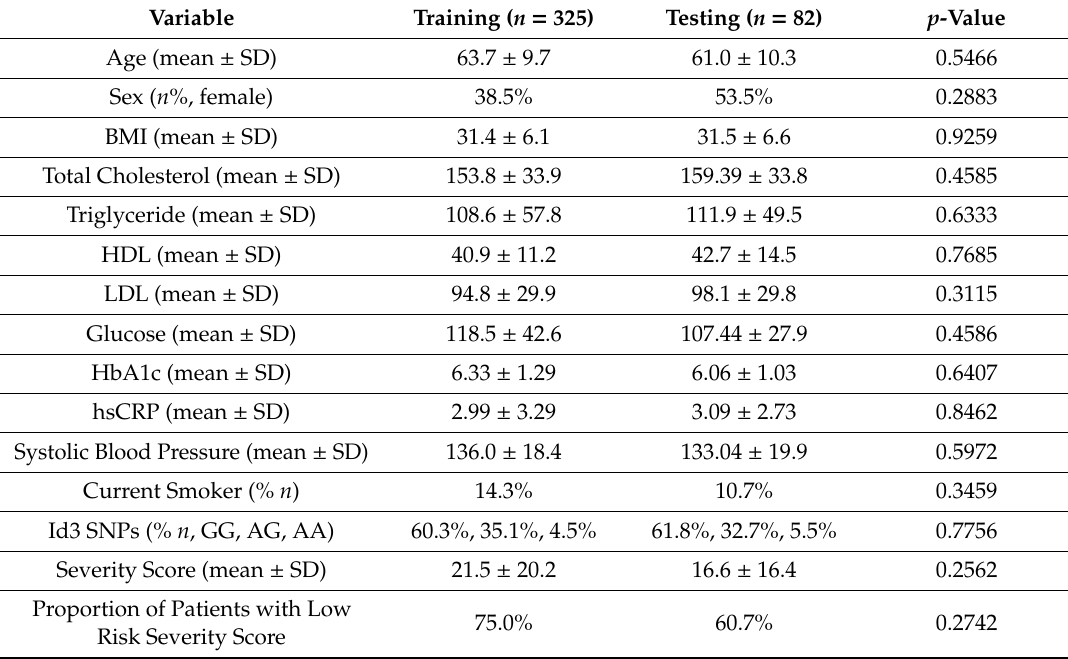
Table 1. Patients characteristics of training and testing